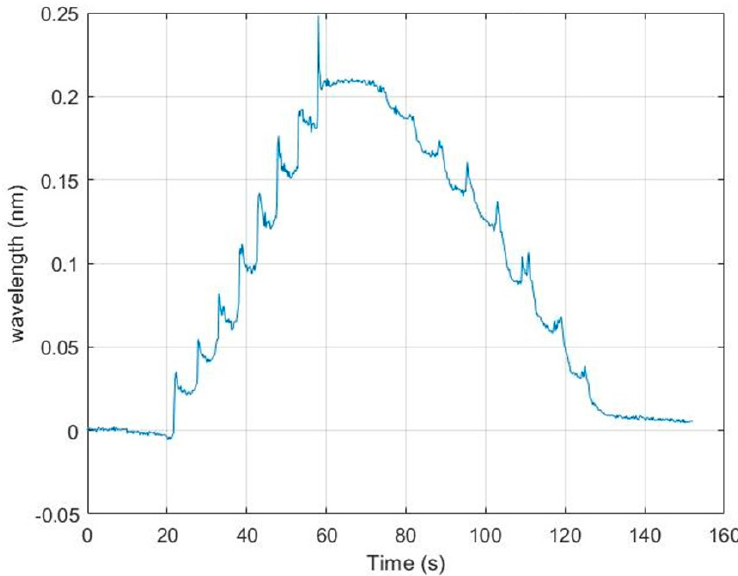
Figure 10. Typical results: wavelength shift against time underneath a compression bandage wrapped multiple times (in this case 8 layers) on a single location on the phantom leg. The displayed wavelength values are strain and temperature